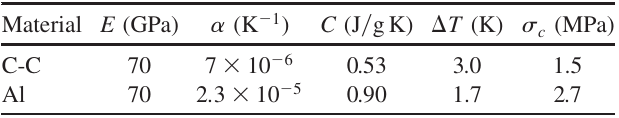
TABLE VI. Mechanical and thermal properties of materials used in the exit window, instantaneous temperature increase, and cyclic thermal stress at the beam